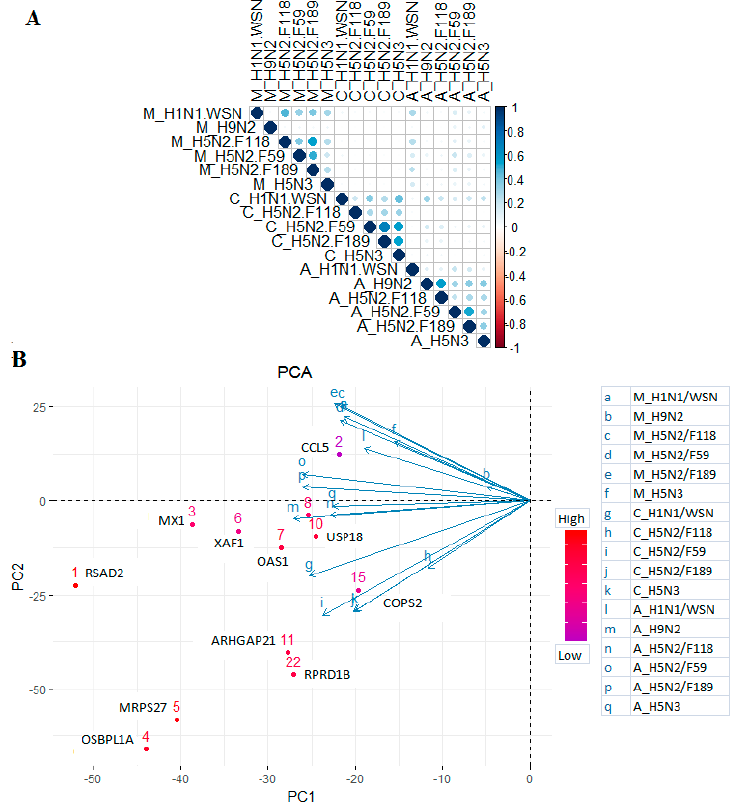
Figure 3. Correlation and clustering of the DEGs. ( A ) Correlation matrix of the DEGs in the three cell lines across the IAV infections at 10 hpi; ( B ) principal component analysis of the DEGs to identify the determinat genes in each cluster (species).